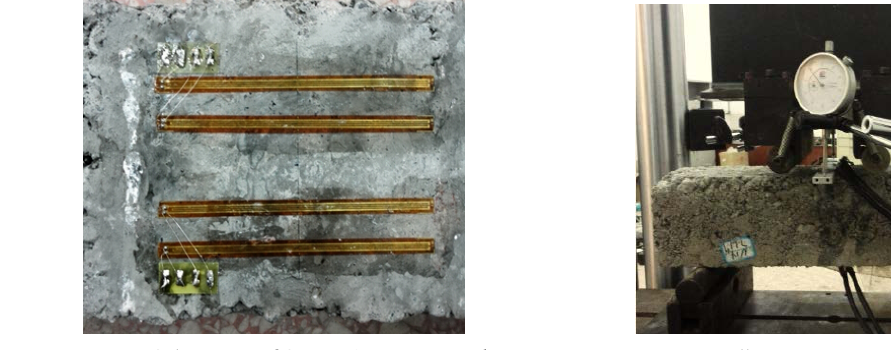
Figure 2: Schematic of Strain Gauges Pasted Figure 3: Installation Drawing of Modulus Test